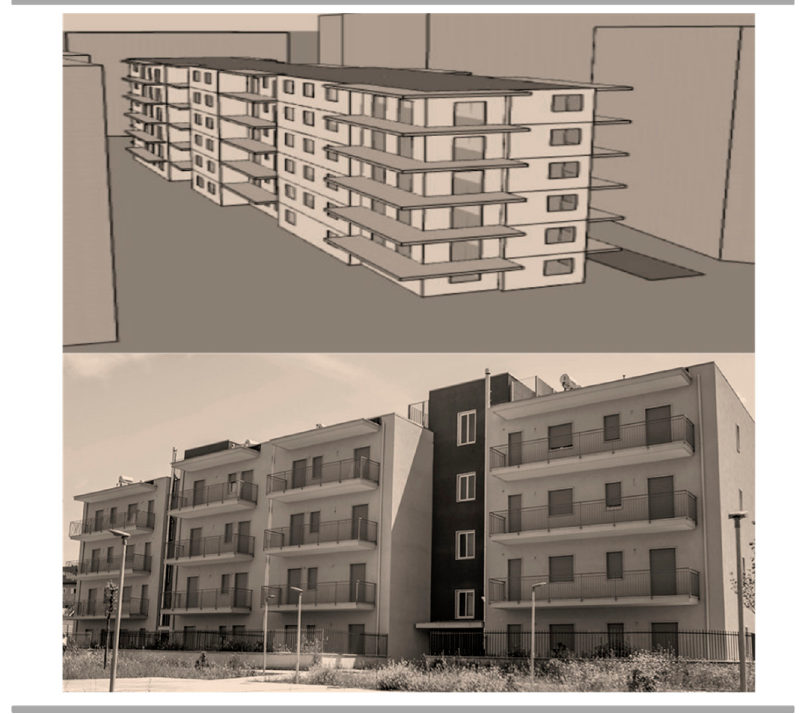
Figure 5. Model rendering and typical building comparison.